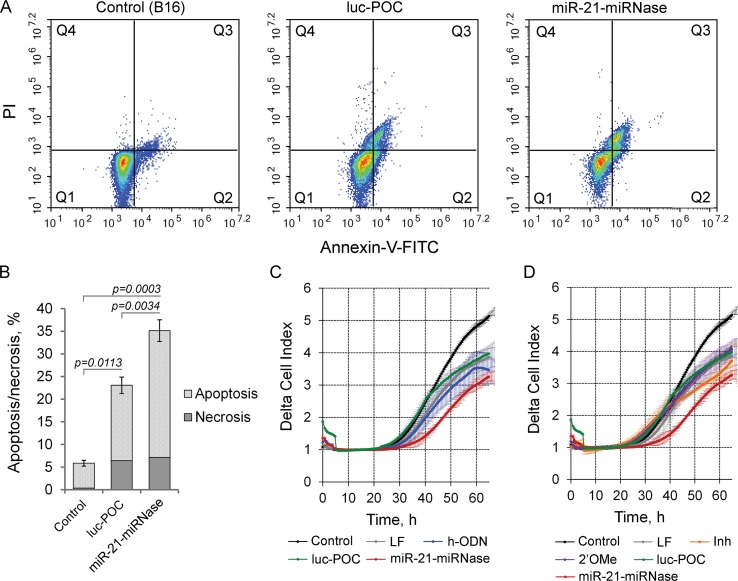
Biological effect of the miR-21-specific miRNase. (A) Apoptotic profile of B16 melanoma cells after transfection with miR-21-miRNase and control luc-POC. Cytofluorimetric analysis of cells after staining with Annexin V-FITC/PI 48 h after transfection with miRNase or luc-POC (1 µM) in complex with Lipofectamine2000. Q1—population of living cells; Q2—Annexin V-FITC+/PI-, early apoptosis; Q3—Annexin V-FITC+/PI+, late apoptosis; Q4—Annexin V-FITC-/PI+, necrosis. (B) Average percentage of apoptotic (early and late apoptosis) and necrotic B16 cell population. Data represent mean ± s.e. of four independent experiments.(C, D) Invasion activity of B16 cells after incubation with Lipofectamine (LF) alone or treated with either hairpin antisense oligonucleotide (h-ODN), hairpin 2′-OMe oligonucleotide (2′-OMe), commercial miR-21 inhibitor (Inh), miR-21-miRNase, and control conjugate (luc-POC) in the concentration of 1 µM. Migration of cells was recorded in real time using the xCELLigence cell analysis system. Control—B16 cells without treatment. Data represent mean ± s.d. of four independent experiments.